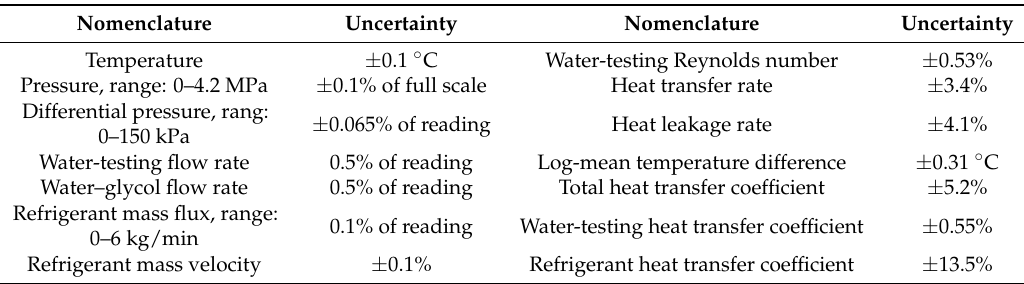
Table 2. The uncertainty of experimental